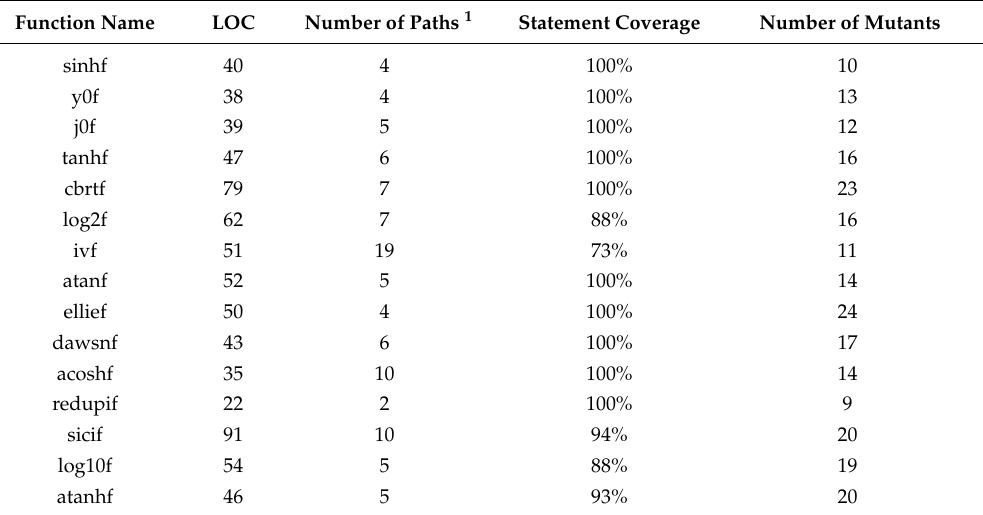
Table 2. Information of Selected